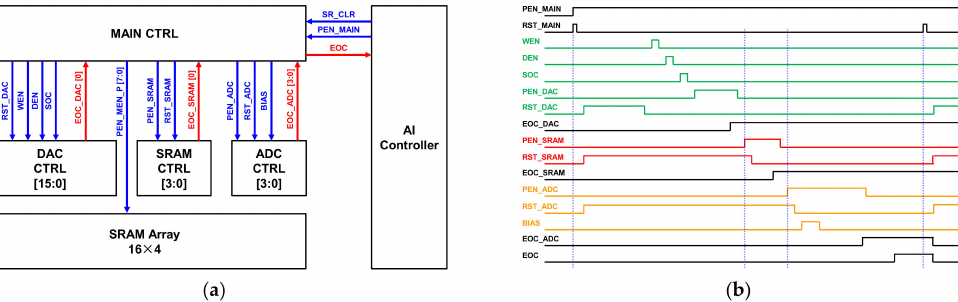
Figure 16. Detailed results of the analog PIM controller: ( a ) block diagram between controllers; ( b ) timing